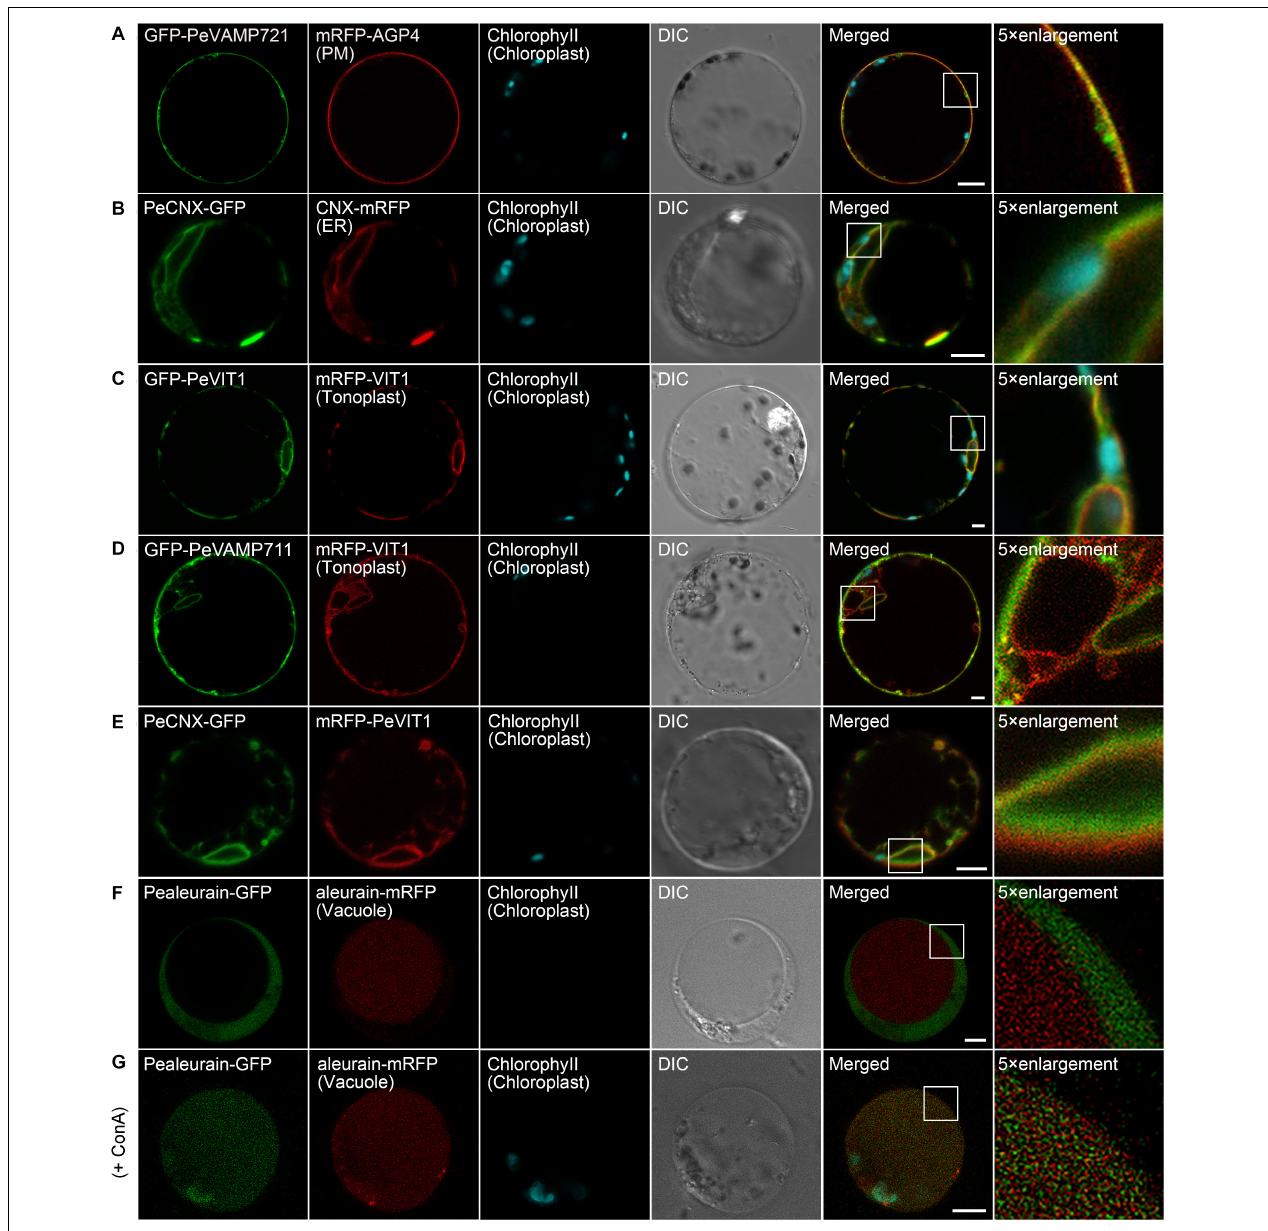
FIGURE 4 | Subcellular localization of endogenous organelle markers on plasma membrane (PM), endoplasmic reticulum (ER), and vacuole of moso bamboo. The constructs were transiently expressed in moso bamboo protoplasts and visualized by confocal laser scanning microscopy (CLSM). (A) Colocalization of GFP–PeVAMP721 with Arabidopsis PM marker protein mRFP–AGP4. (B) Colocalization of PeCNX–GFP with Arabidopsis ER marker CNX–mRFP. (C) Colocalization of GFP–PeVIT1 with Arabidopsis tonoplast marker mRFP–VIT1. (D) Colocalization of GFP–PeVAMP711 with Arabidopsis tonoplast marker